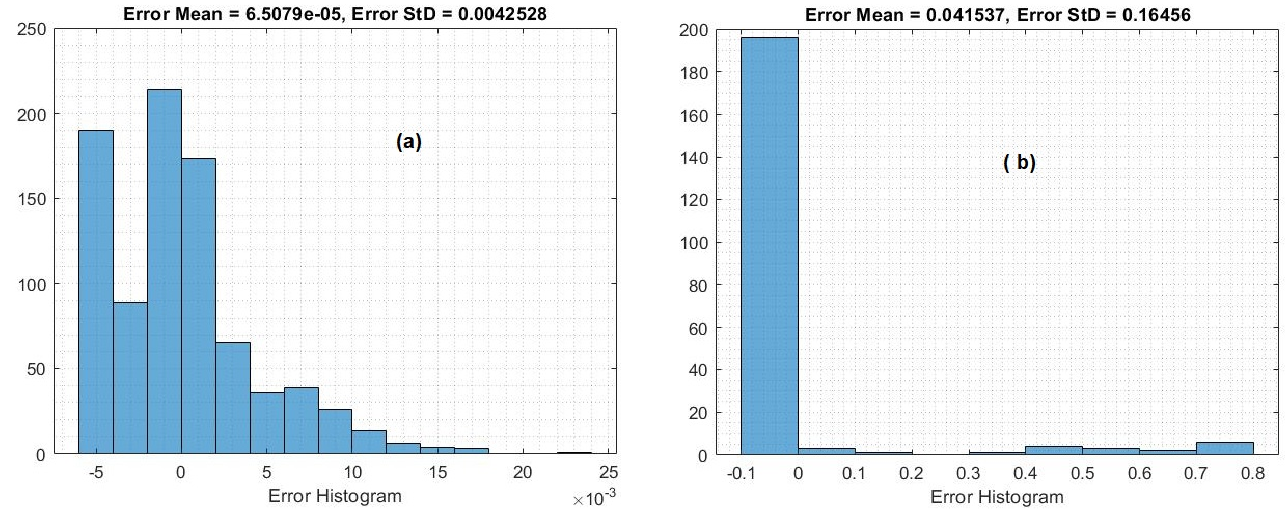
Figure 9. Error histograms of the LSTM model’s predictions of the prices of the Ethereum cryptocur- rency in ( a ) training and ( b ) testing.